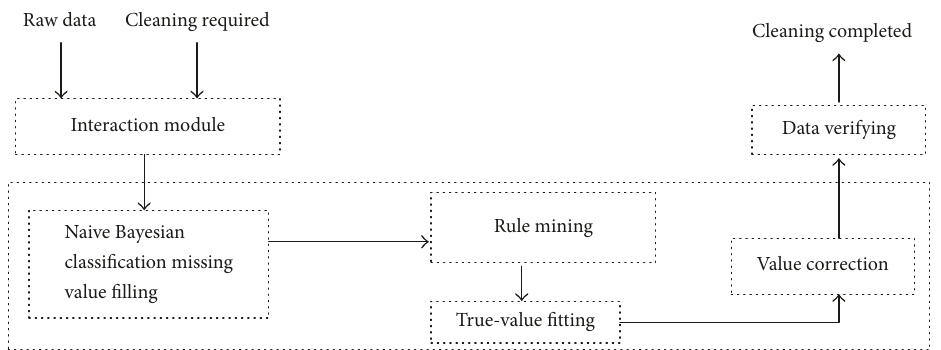
Figure 1: The flowchart of data cleaning and